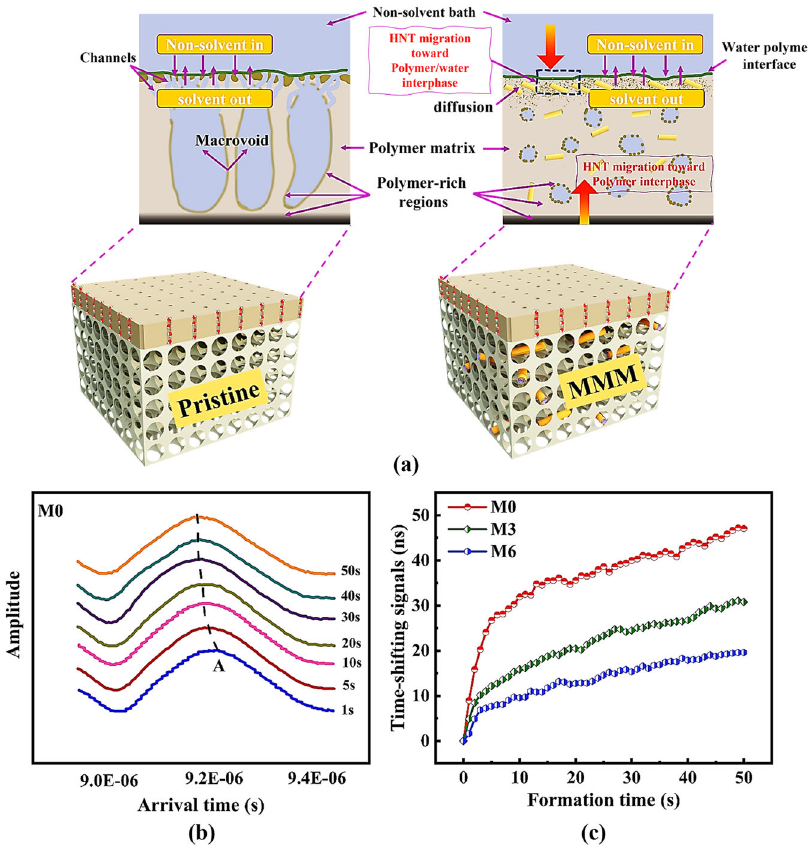
Fig. 6 Proposed formation, kinetics and thermodynamics. Proposed formation mechanism of PSF/EVOH/HNTs MMMs ( a ), Ultrasonic signal spectra during membrane formation ( b ) and ultrasonic signal movement in time-domain during the membrane formation ( c ). Table 1. The properties of